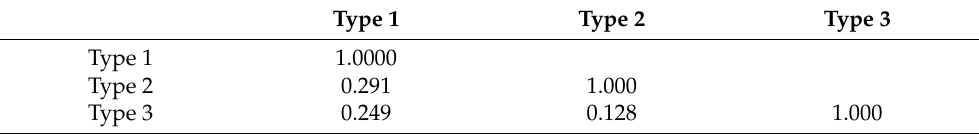
Table 4. Correlations.